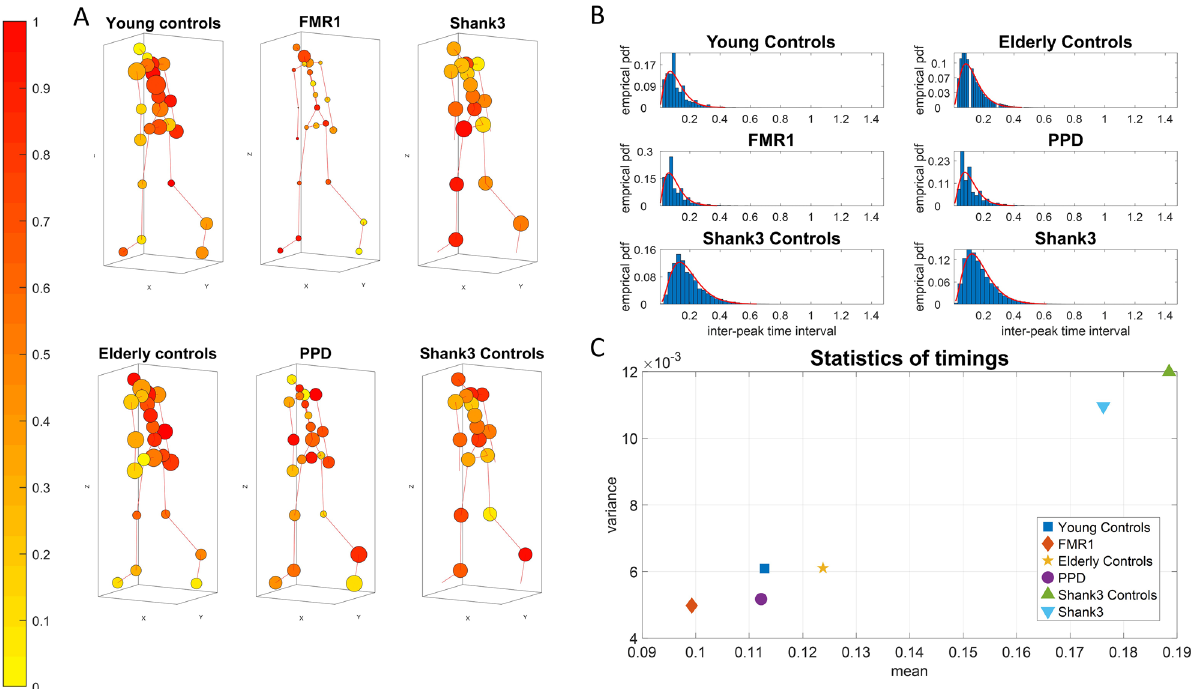
Figure 1. GC optimal lag maps and timing information. ( A ) Anthropomorphic network representation of human walking patterns. The nodes’ size is proportional to the number of outgoing links connected to the other nodes in the network (out degree) of the average GC network. The color of the nodes is the maximum optimal lag response of a node with the rest of the body for the average Lag Response network. A unit of one lag refers to the distance in time between two peaks. The actual physical time between the two peaks can vary. ( B ) The frequency histograms depict the distribution of the inter-peak timings for each group. The empirical distributions are well fitted by the gamma family of distributions. ( C ) Large departure from ideal patterns at college age are observed in the youngest developing (still growing) children and in the elderly controls. Further separation of the various pathologies is captured in relation to age-matched controls. For the youngest controls (5–7 years old) from the SHANK3 dataset, the average inter-peak timing is 0.1885s with a std of 0.1095, compared to the SHANK3 participants 0.1762 with a std of 0.1047. For the young controls of college age, 0.1129 with a std of 0.0780. For the elderly controls, 0.1238 with a std of 0.0781. For the FMR1 carriers, 0.0993 with a std of 0.0705. For the PPDs, 0.1122 with a std of